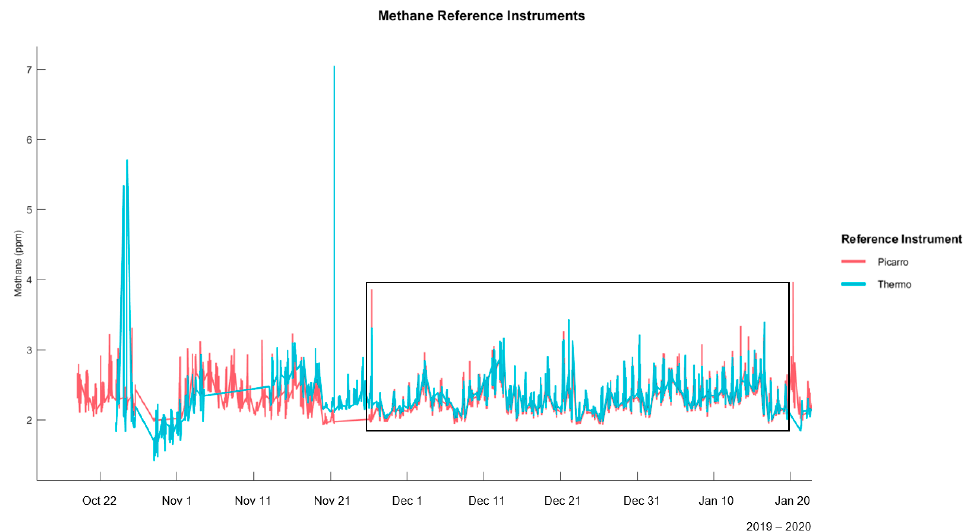
Figure 8. Timeseries of Picarro and Thermo reference instruments, with the period of data used for analysis boxed in.